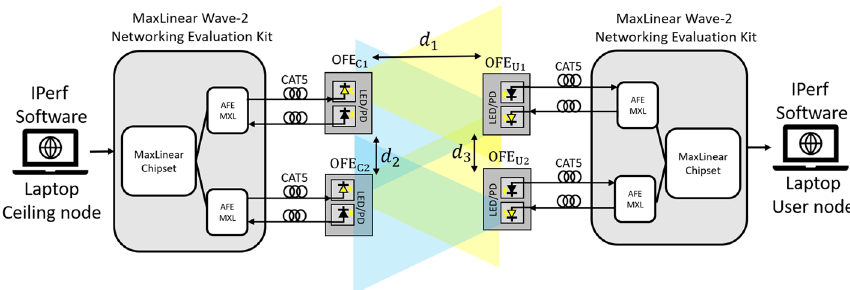
Fig. 20 Test set-up for G.vlc MIMO LiFi with phoneline or powerline